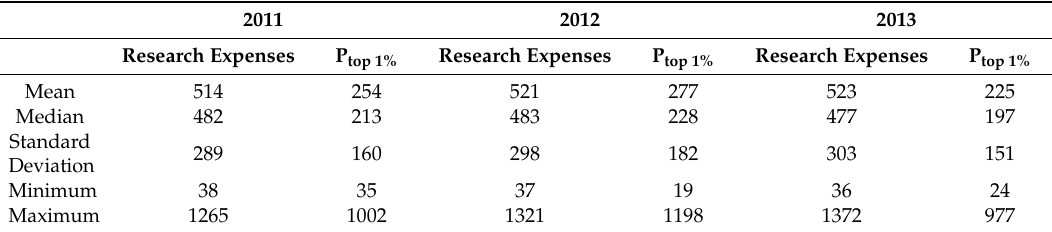
Table 1. Descriptive statistics over